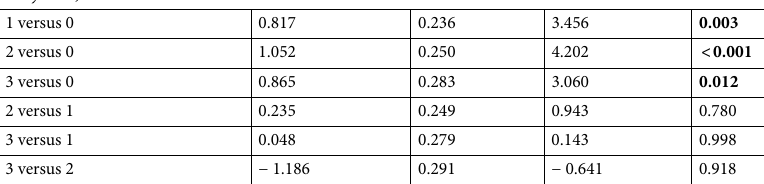
higher when individuals are within one meter from each other, compared to further distances (Tukey test; one meter versus within 10 m: p < 0.001; one meter versus more than 10 m: p < 0.001) (Fig. 5b). No difference was found between other distances (see Table 2 for full results). Goodman and Kruskal’s lambda test revealed no significant association between the two nominal fixed factors kinship and distance (λ = 0.010; T = 0.200; p = 0.841).